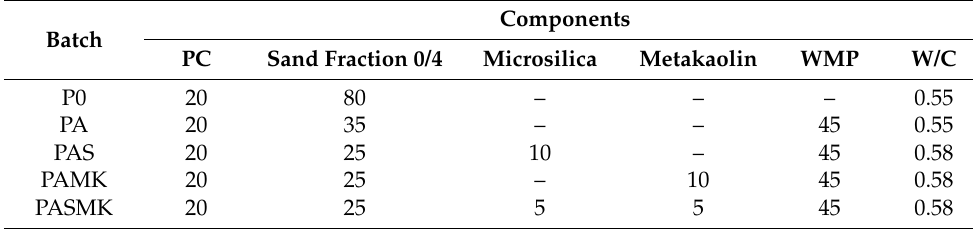
Table 4. Compositions of mortar forming mixtures (mass